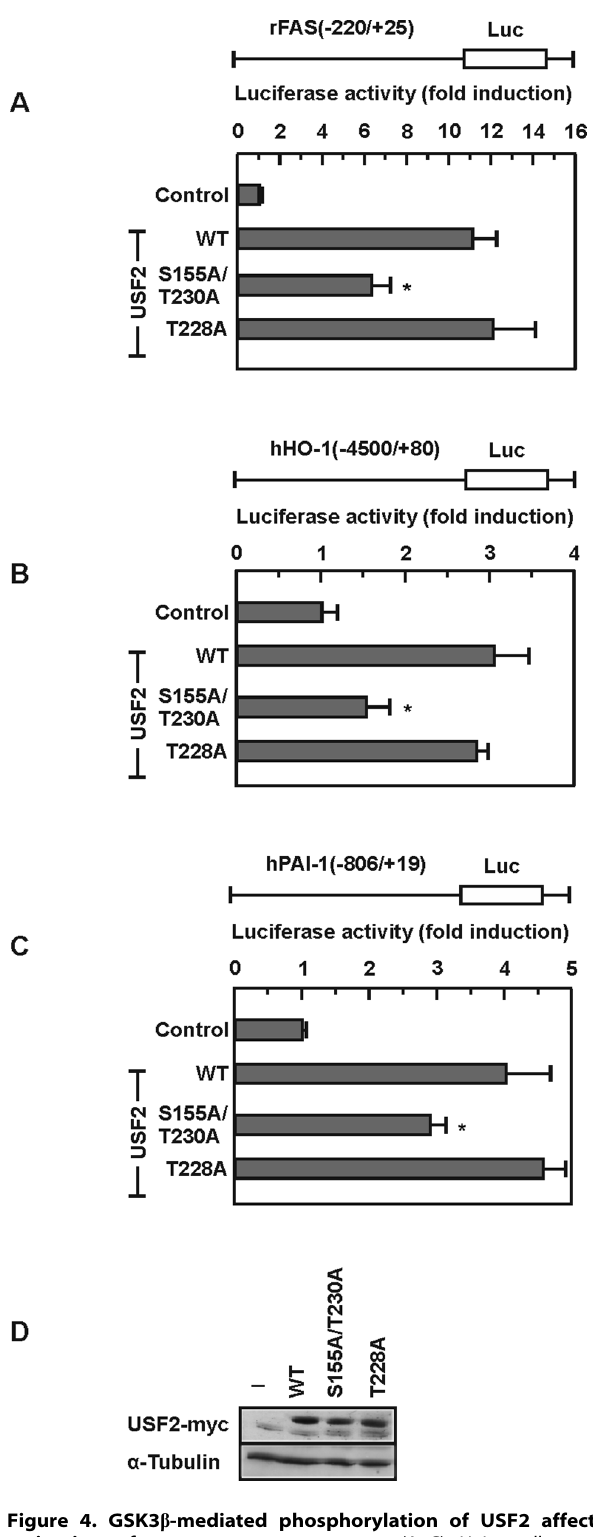
Figure 4. GSK3 b -mediated phosphorylation of USF2 affects activation of target gene promoters. (A–C) HeLa cells were cotransfected with the indicated luciferase gene construct and with WT or mutant p3xFLAG-USF2-myc-CMV24 or the appropriate empty vector. The measured luciferase activity is plotted as fold induction compared to the luciferase activity measured in the control transfected with the empty expression vector. *, significant difference WT vs. mutant. (D) Representative Western blot of the transfected